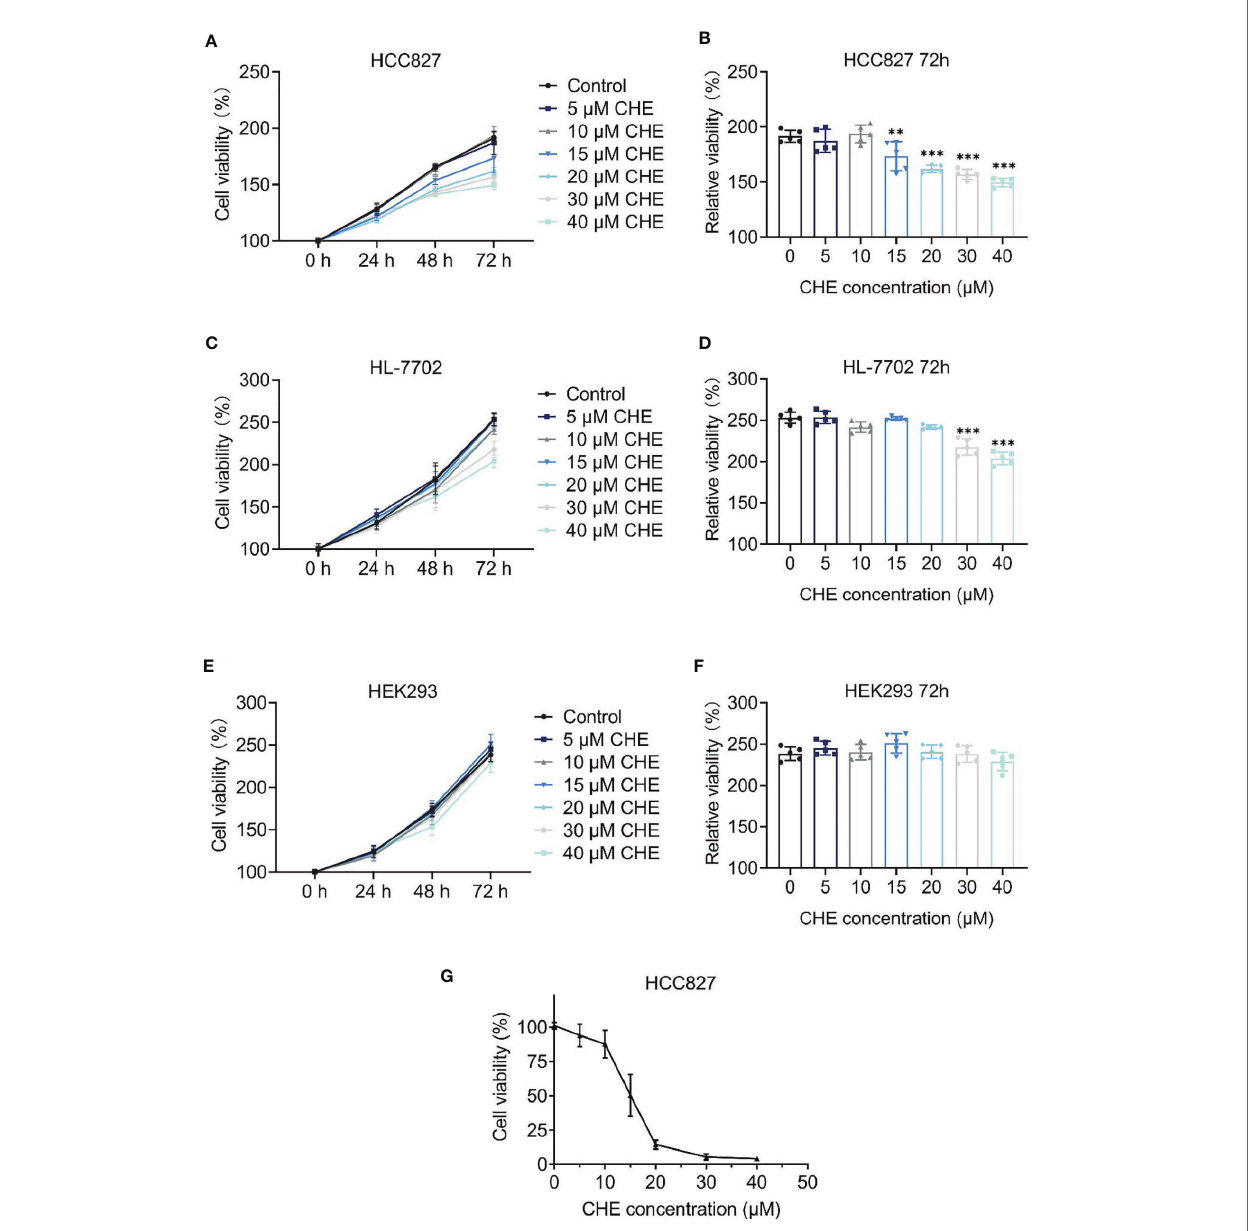
FIGURE 1 | The cell proliferation of HCC827, HL-7702, and HEK-293 after treatment with CHE. (A, C, E) Cell viability of HCC827, HEK-293, HL-7702 cells after treatment with CHE through the CCK-8 assay, respectively. CHE induced the apoptosis of HCC827 cells. (B, D, F) The relative viability of HCC827, HEK-293, HL-7702 cells after treatment with CHE at 72 h, respectively. (G) The MTT result of HCC827 after treatment with CHE. (***p < 0.001, **p <